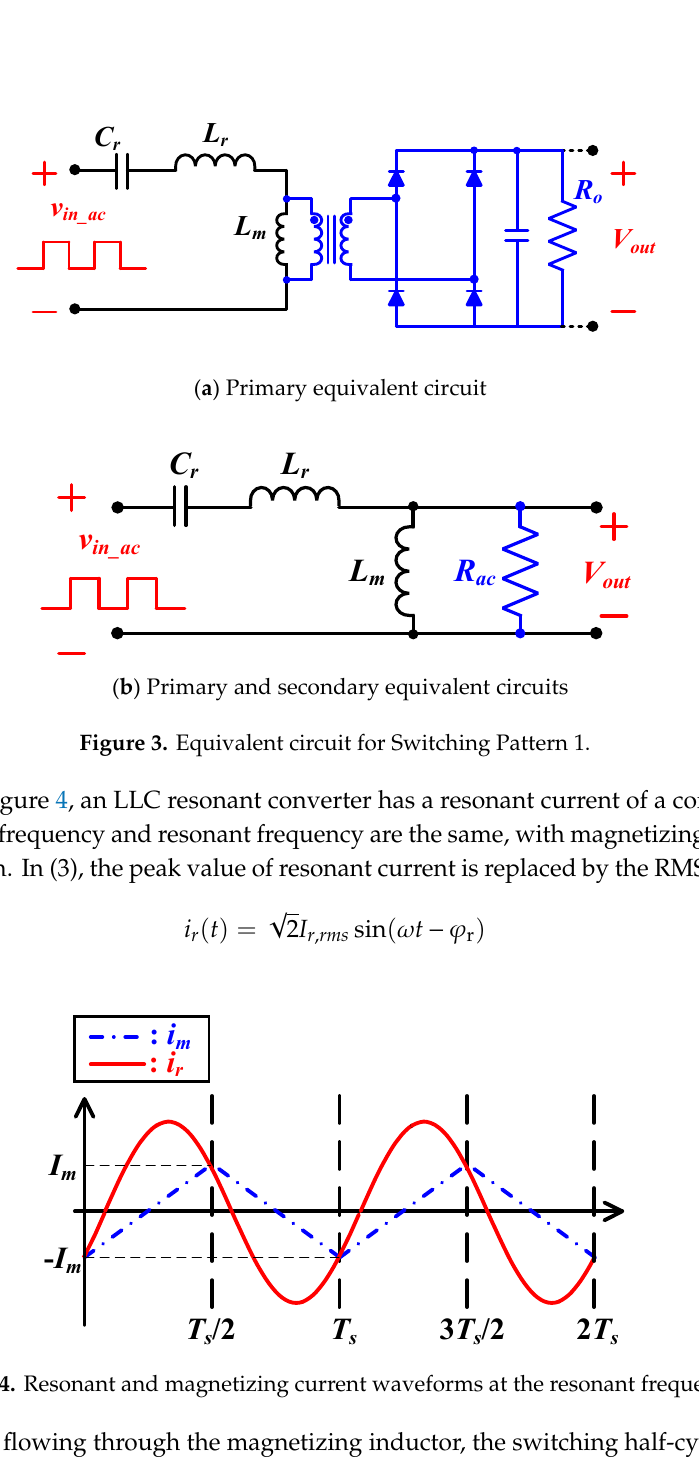
( d ) Switching Pattern 4 Figure 2. The current paths depending on the switching patterns (Patterns 1~4). For Switching Pattern 1, + V in is applied to the upper LLC resonance tank when switches S 1 , S 5 ,